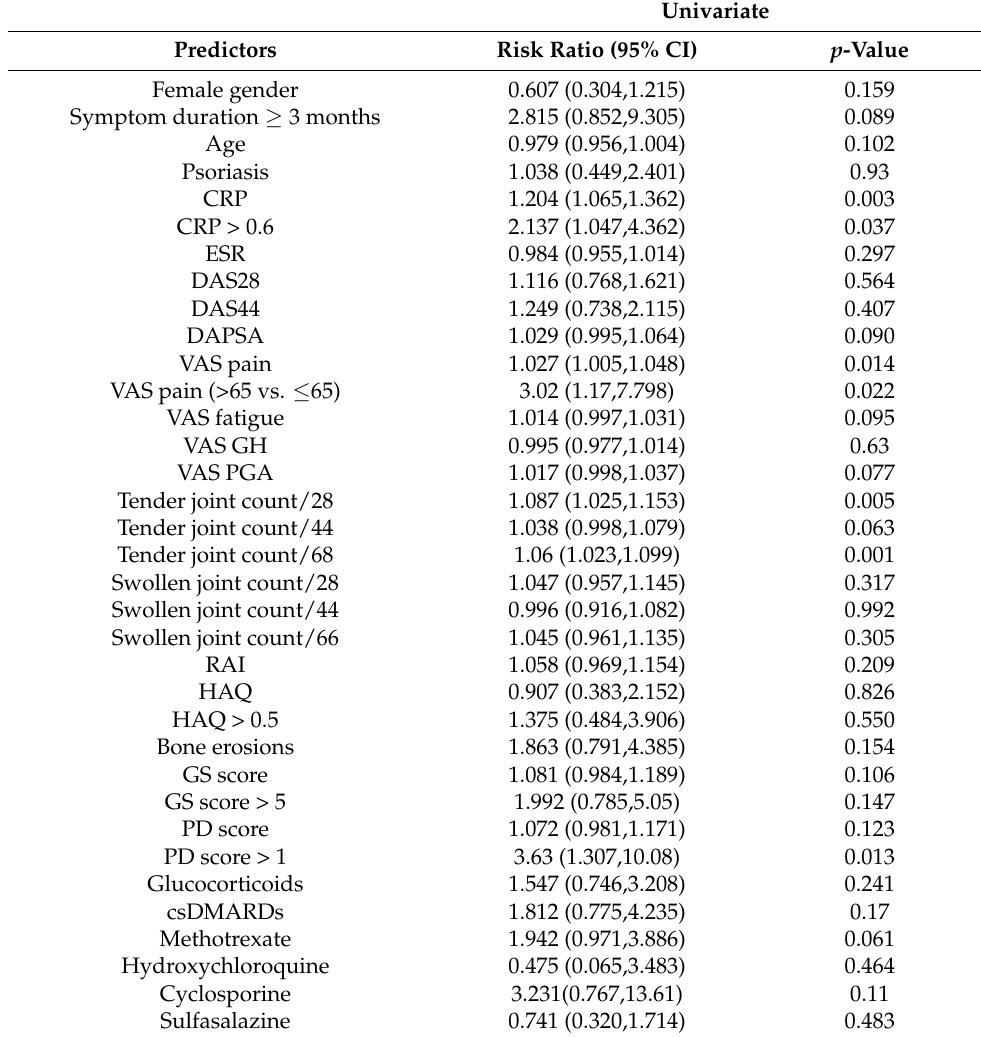
Table 2. Results of the univariate Cox regression analyses.